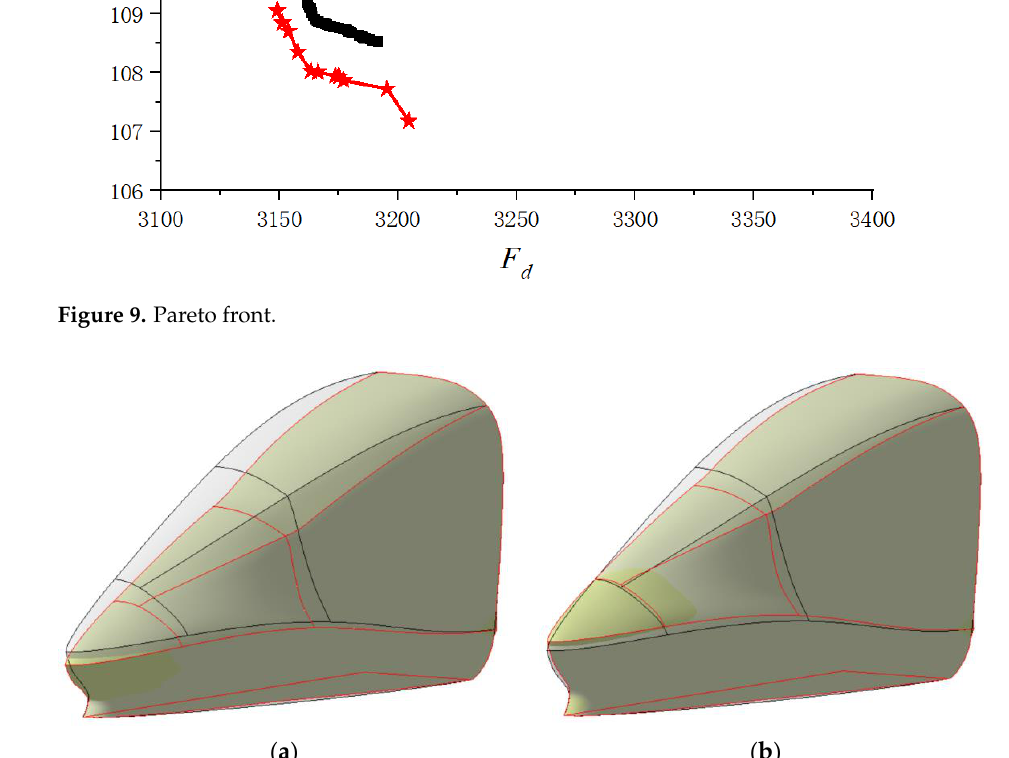
Figure 10. Comparison of optimal and original streamlined heads: ( a ) Optimal streamlined head for the aerodynamic resistance, ( b ) Optimal streamlined head for dipole noise source.